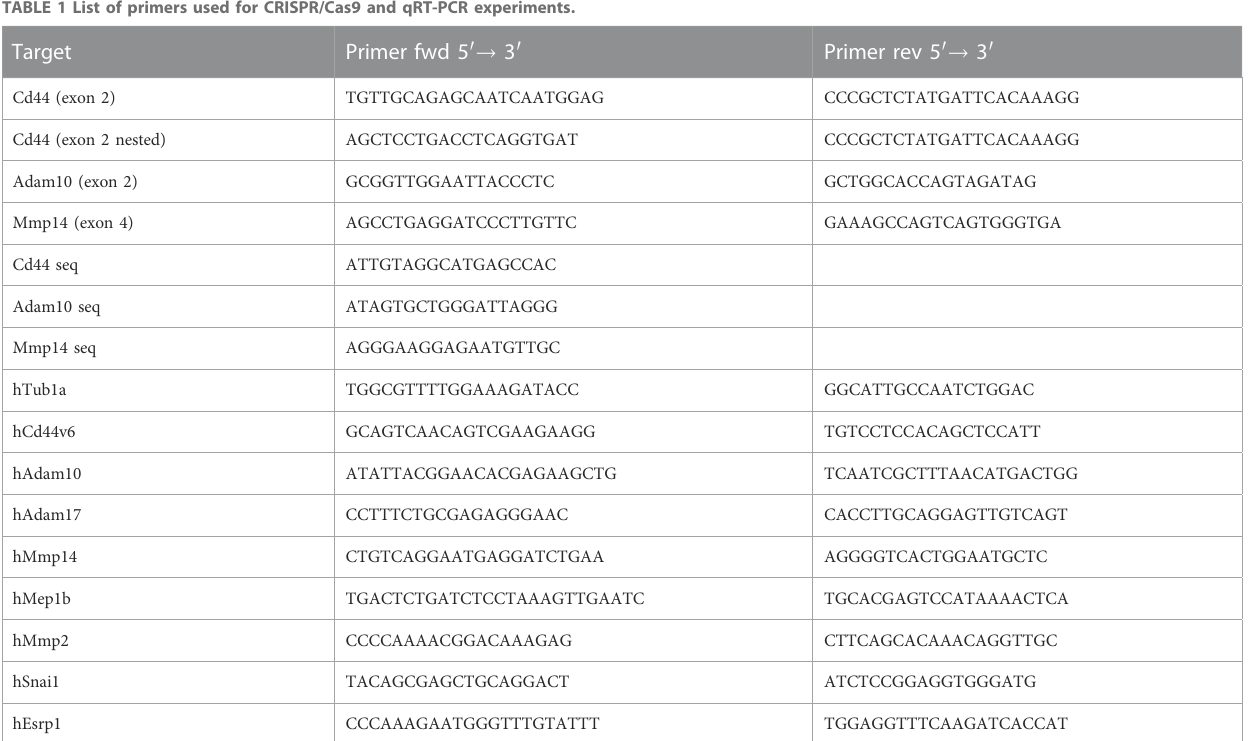
TABLE 1 List of primers used for CRISPR/Cas9 and qRT-PCR experiments.